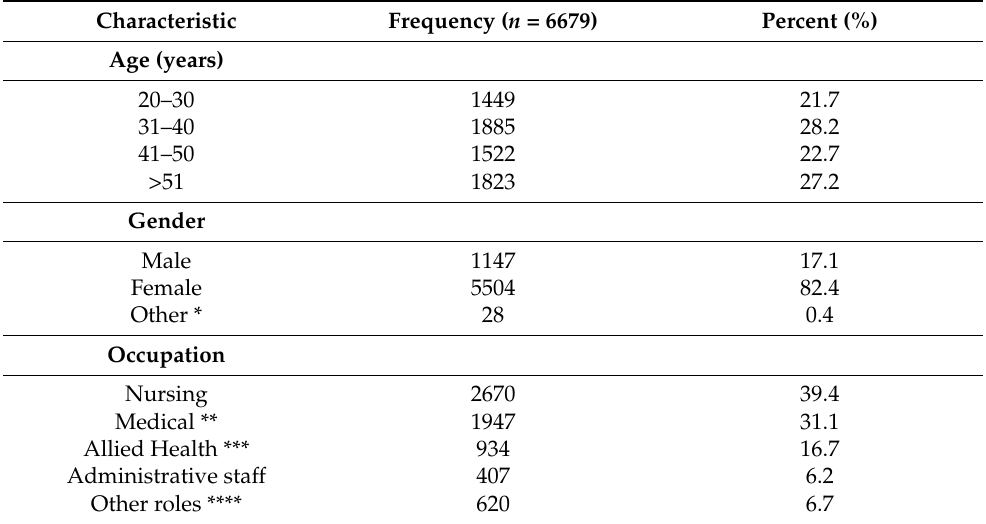
Table 1. Participants’